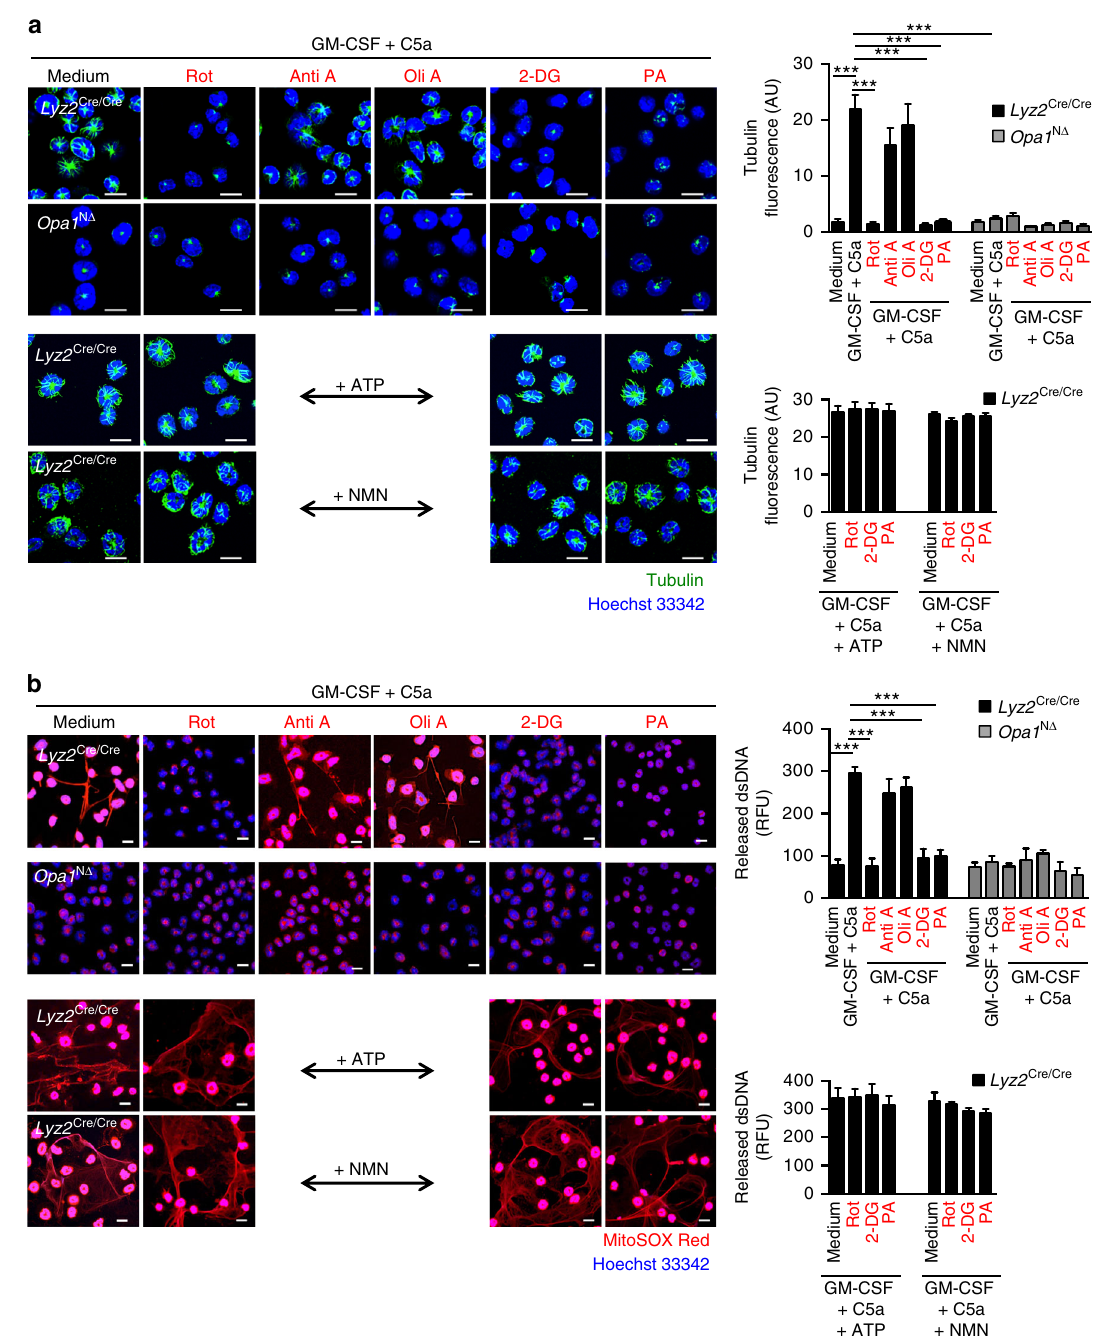
Fig. 6 Pharmacological inhibition of mitochondrial complex I activity and glycolysis blocks microtubule network formation and extracellular DNA release. a Confocal microscopy. Opa1 N Δ and control neutrophils were pretreated with 10 µ M rotenone (Rot), 5 µ g per ml antimycin A (Anti A), 2.5 µ g per ml oligomycin A (Oli A), 3 mM 2-DG, or 0.5 µ M piericidin A (PA) for 30 min before GM-CSF priming and subsequent C5a activation. Lower panels: control mouse neutrophils were pretreated with 100 µ M ATP or 500 µ M NMN, incubated in presence or absence of the indicated inhibitors, and subsequently stimulated with GM-CSF/C5a. Microtubules were stained with anti- α -tubulin antibody (green). Bars, 10 µ m. Right: Quanti fi cation of microtubule network formation was performed by automated analysis of microscopy images using Imaris software. Values are means ± SEM. *** p < 0.001; n = 3. b Confocal microscopy. Neutrophils of Opa1 N Δ and control mice were pretreated with 10 µ M Rot, 5 µ g per ml Anti A, 2.5 µ g per ml Oli A, 3 mM 2-DG, or 0.5 µ M PA for 30 min before GM-CSF priming and subsequent C5a activation. Lower panels: control mouse neutrophils were pretreated with 100 µ M ATP or 500 µ M NMN, incubated in presence or absence of the indicated inhibitors, and subsequently stimulated with GM-CSF/C5a. Extracellular DNA was stained with MitoSOX ™ Red and the nucleus with Hoechst 33342 (blue). Bars, 10 µ m. Right: quanti fi cation of released dsDNA in supernatants of activated neutrophils. Values are means± SEM. *** p < 0.001; n = 3. Additional data using human neutrophils are provided in Supplementary Figs. 7 and